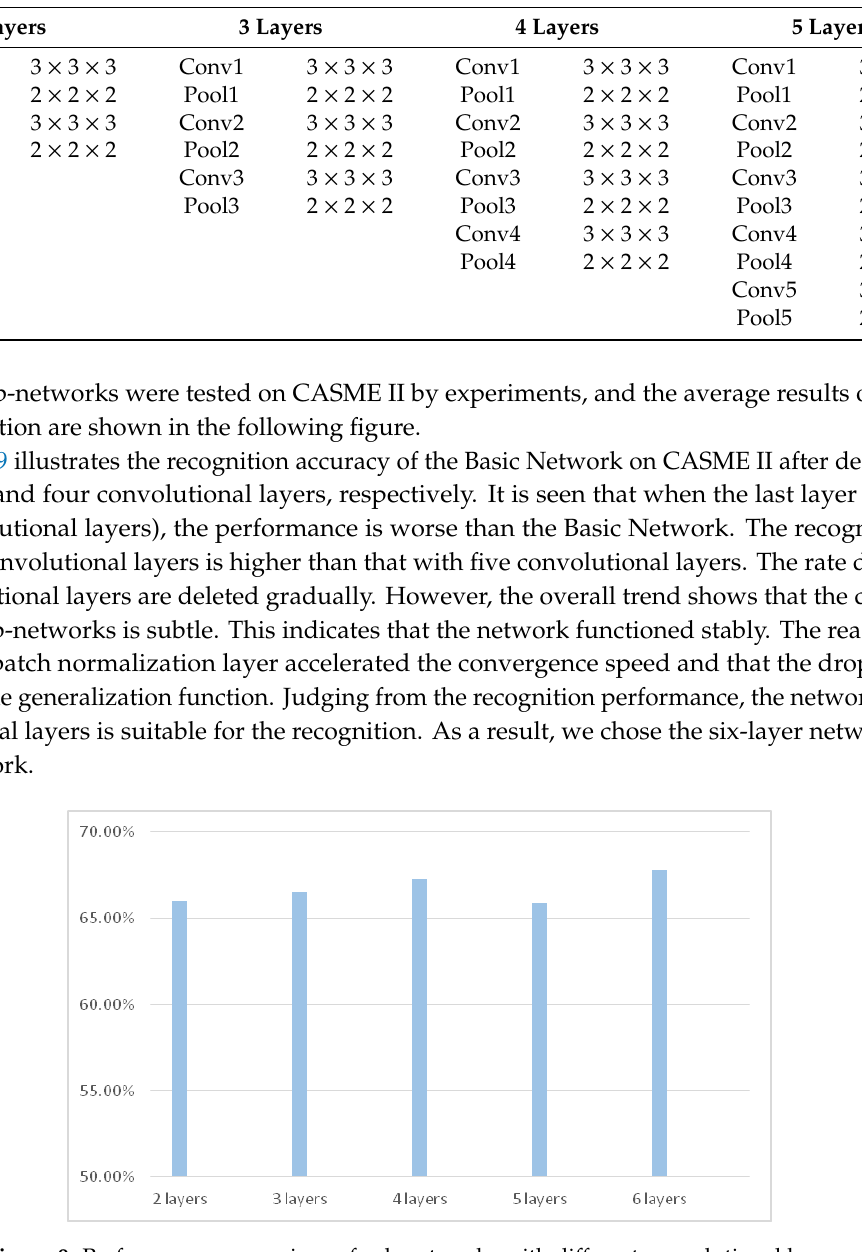
Table 3. The network structures of sub-networks.